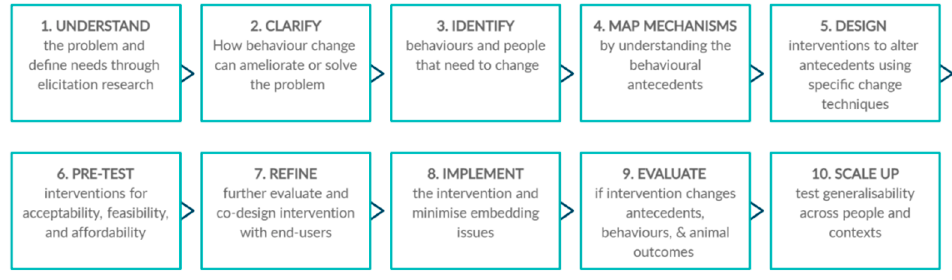
Figure 1. Ten-Task guide to the design and evaluation of behaviour change interventions [9].